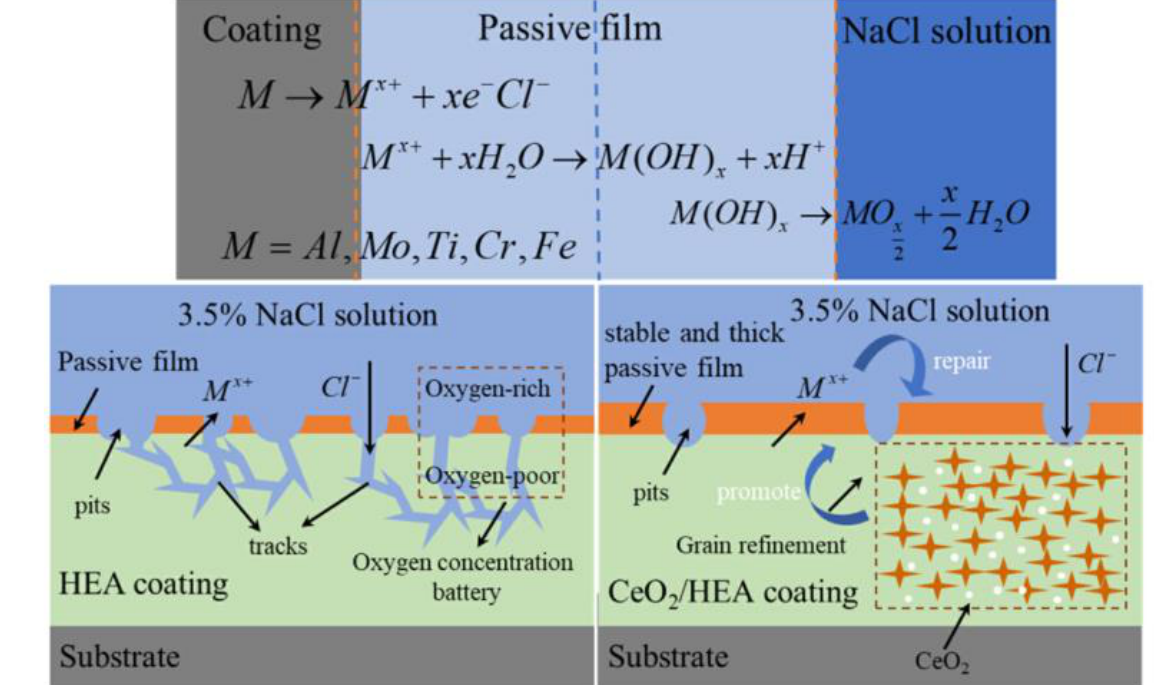
Figure 4. Schematic diagram of corrosion in 3.5% NaCl solution. Reprinted with permission from [63] 2021 Elsevier.